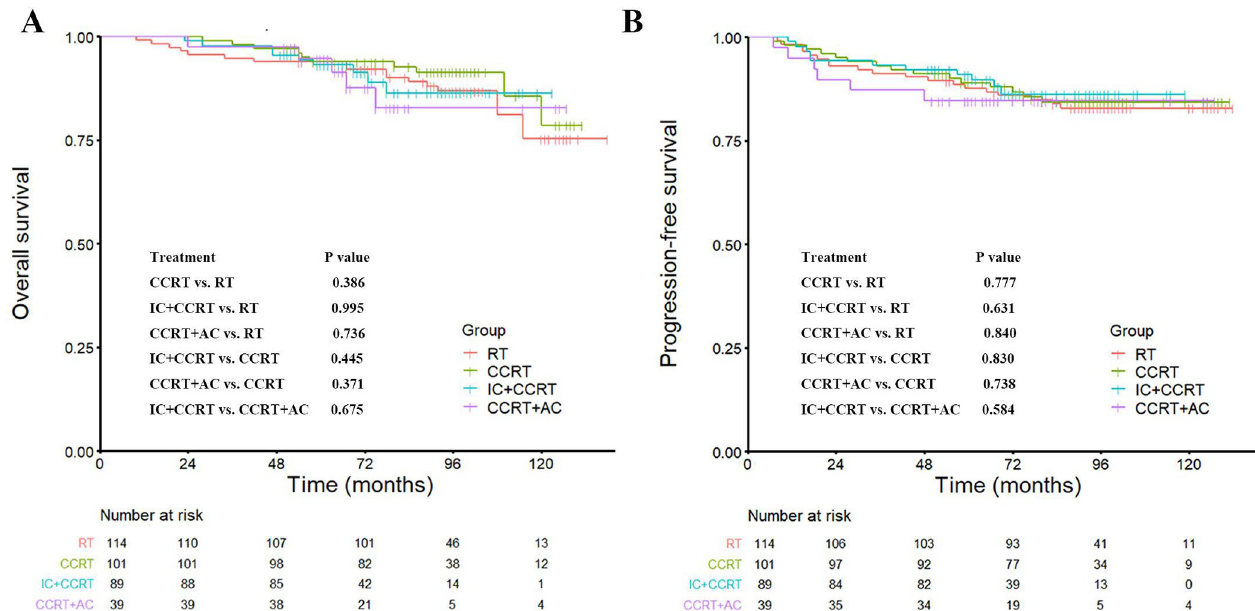
Fig 2. Kaplan–Meier survival curves for the RT, CCRT, IC + CCRT, and CCRT + AC groups. (A) overall survival, (B) progression-free survival. P values are calculated with the χ 2 test. Abbreviation: RT = radiotherapy, CCRT = concurrent chemoradiotherapy, IC = induction chemotherapy, AC = adjuvant